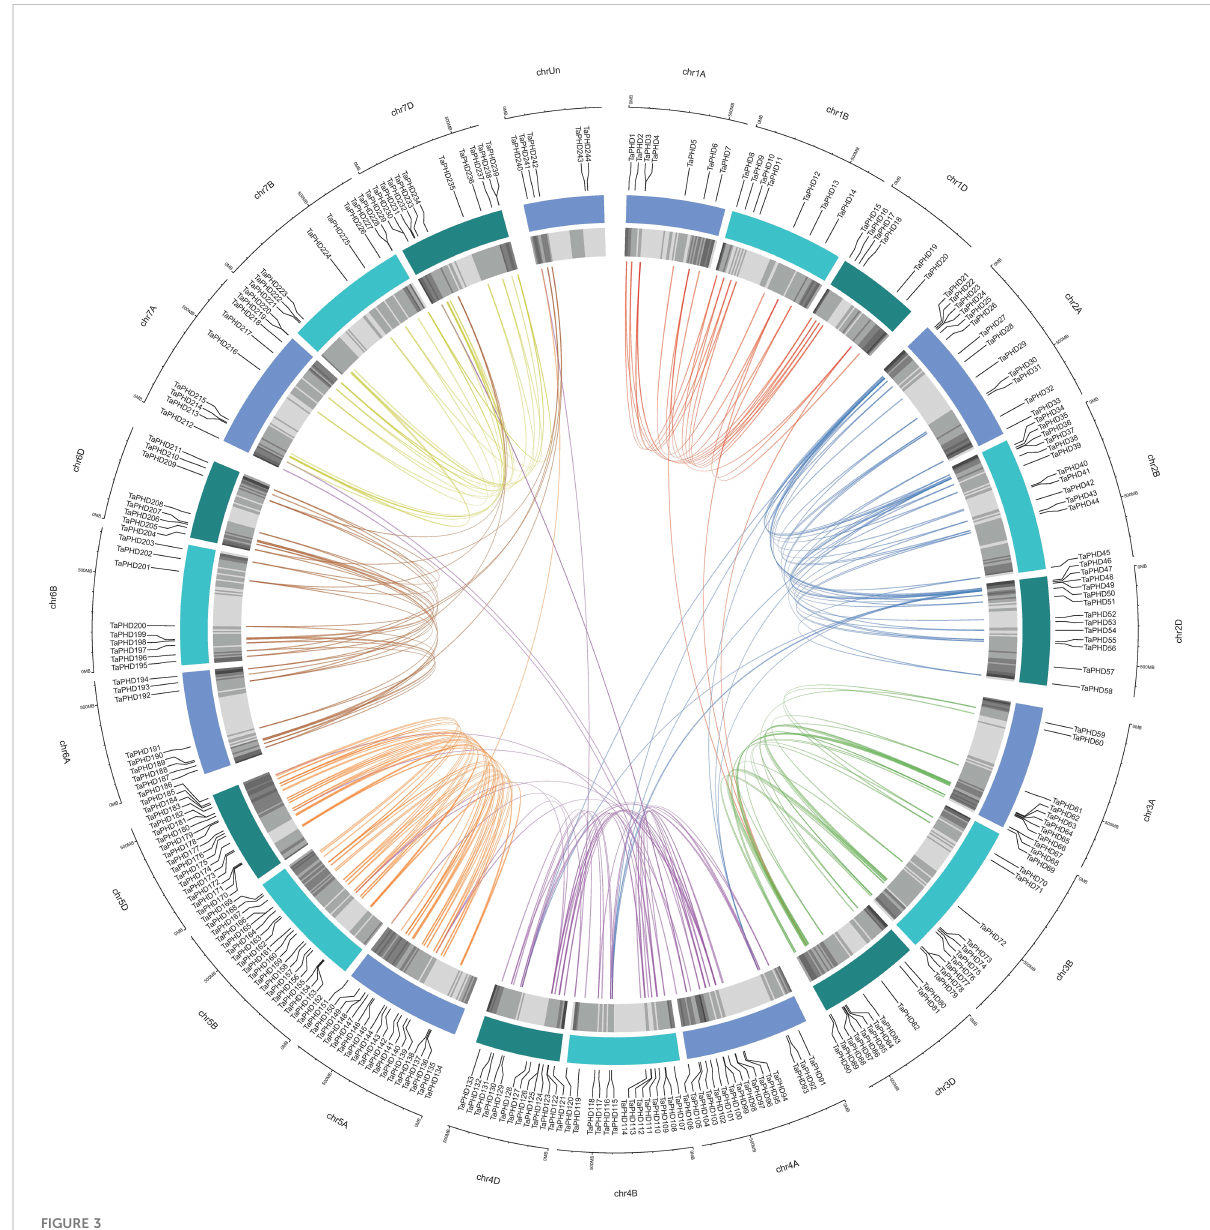
FIGURE 3 Chromosomal localization of TaPHDs. The light blue column represents the chromosome. The depth of blue in the columns represent the density of genes on the